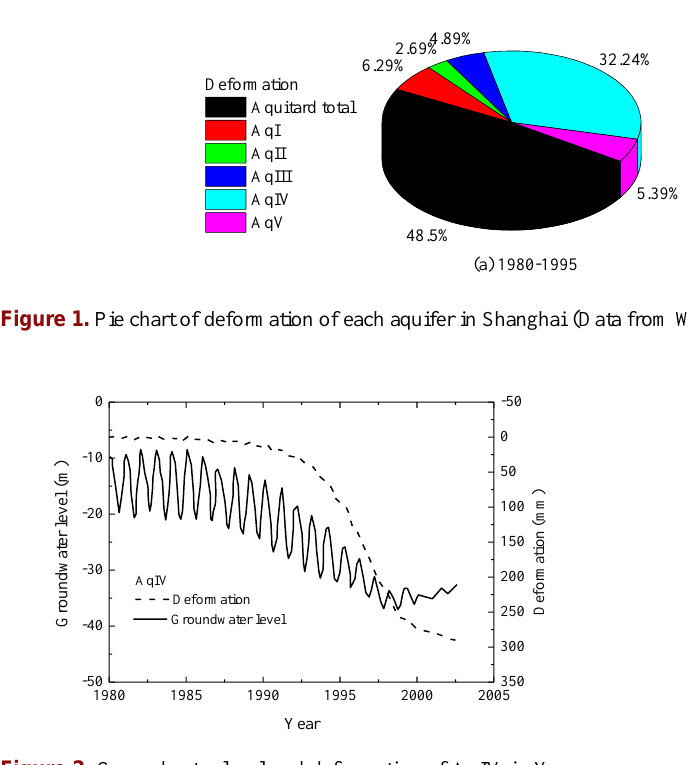
Figure 3. Comparison of simulated deformation using Cosserat mechanics to measured deformation of AqIV at Laodong Park (modified from Shen et al.,